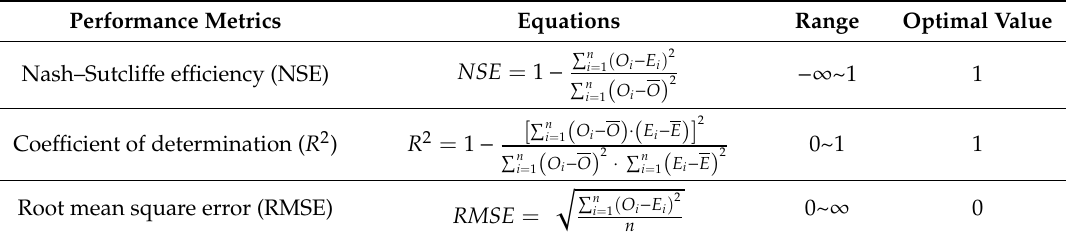
Table 1. Performance metrics employed in this study. O and O indicate the observed runo ff and observed runo ff mean, respectively. E is the simulated runo ff and E is the simulated runo ff mean. n is the number of